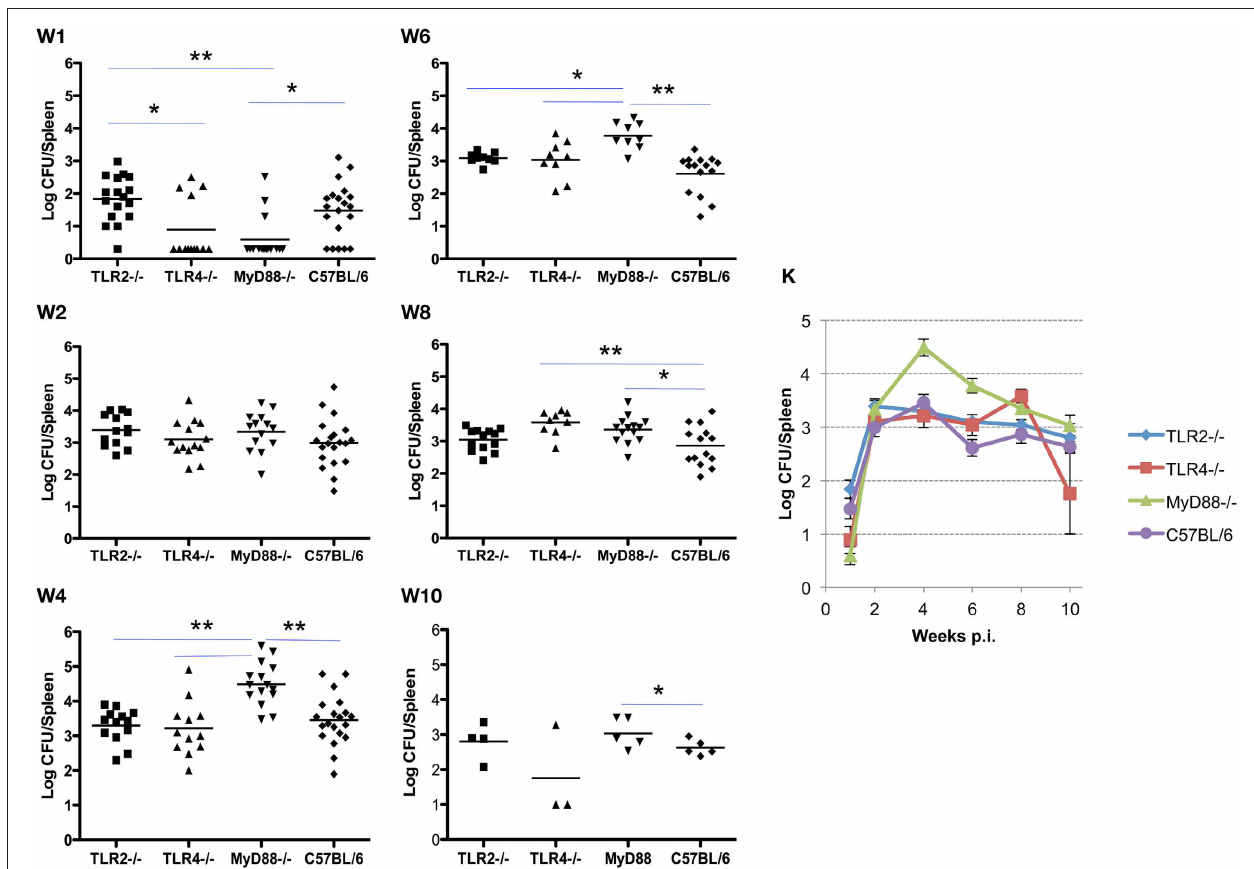
FIGURE 2 | TLR4 and MyD88 are required to control and clear Brucella from the spleens. Groups of TLR2 − / − , TLR4 − / − , MyD88 − / − and C57BL/6 mice were aerosol exposed to B. melitensis 16M. The spleens were collected at weeks 1 (panel W1 ), 2 (panel W2 ), 4 (panel W4 ), 6 (panel W6 ), 8 (panel W8 ),